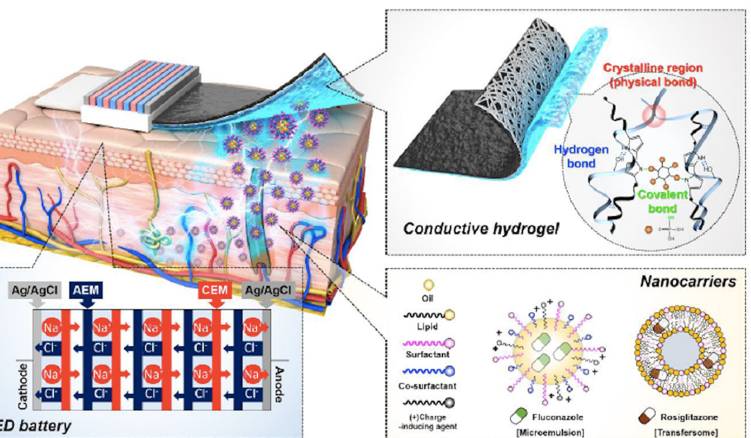
Figure 2. Schematic of the reverse electrodialysis (RED)-driven iontophoretic patch and each component in which the RED battery is operated by the transport of Na + and Cl − ions. The polypyrrole- appended polyvinyl alcohol electroconductive hydrogel patches are constructed with the RED system. Reprinted with permission from ref 24. Copyright 2020 American Chemical Society.